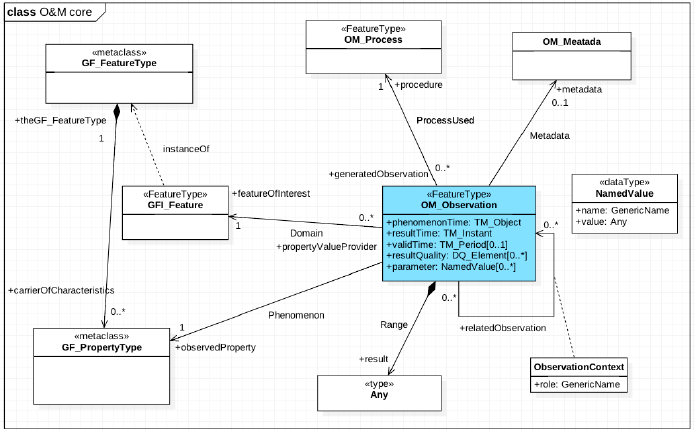
Figure 1. Core class diagram of Observations and Measurements (O&M) conceptual model.